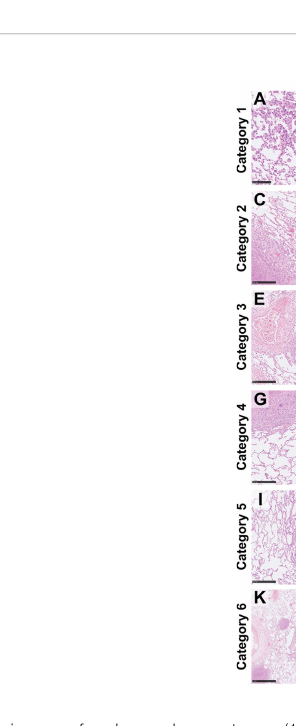
FIGURE 1 | Representative images of each granuloma category (1 – 6) for both rhesus and cynomolgus macaques. HE. Category 1 (A, B) granulomas are small, unorganised, diffuse foci of mixed in fl ammatory cells but lack a peripheral cuff of lymphocytes. Category 2 (C, D) granulomas consist of similar cells types as category 1 lesions but are larger and more de fi ned, becoming circular in shape. Category 3 (E, F) granulomas are the same as category 2 but with the addition of focal necrosis. Category 4 (G, H) granulomas are an organised structure that are well circumscribed and consist mainly of macrophages and evidence of a few peripheral lymphocytes. Category 4 lesions that exhibit necrotic foci with degenerate neutrophils are classed as category 5 (I, J) . Classic, largely well-demarcated granulomas with central, caseous necrosis and a variable rim of lymphocytes are classi fi ed as category 6 (K, L) . Bars in micrographs (A, B) = 100µm, (C – J) = 250µm, (K, L) =